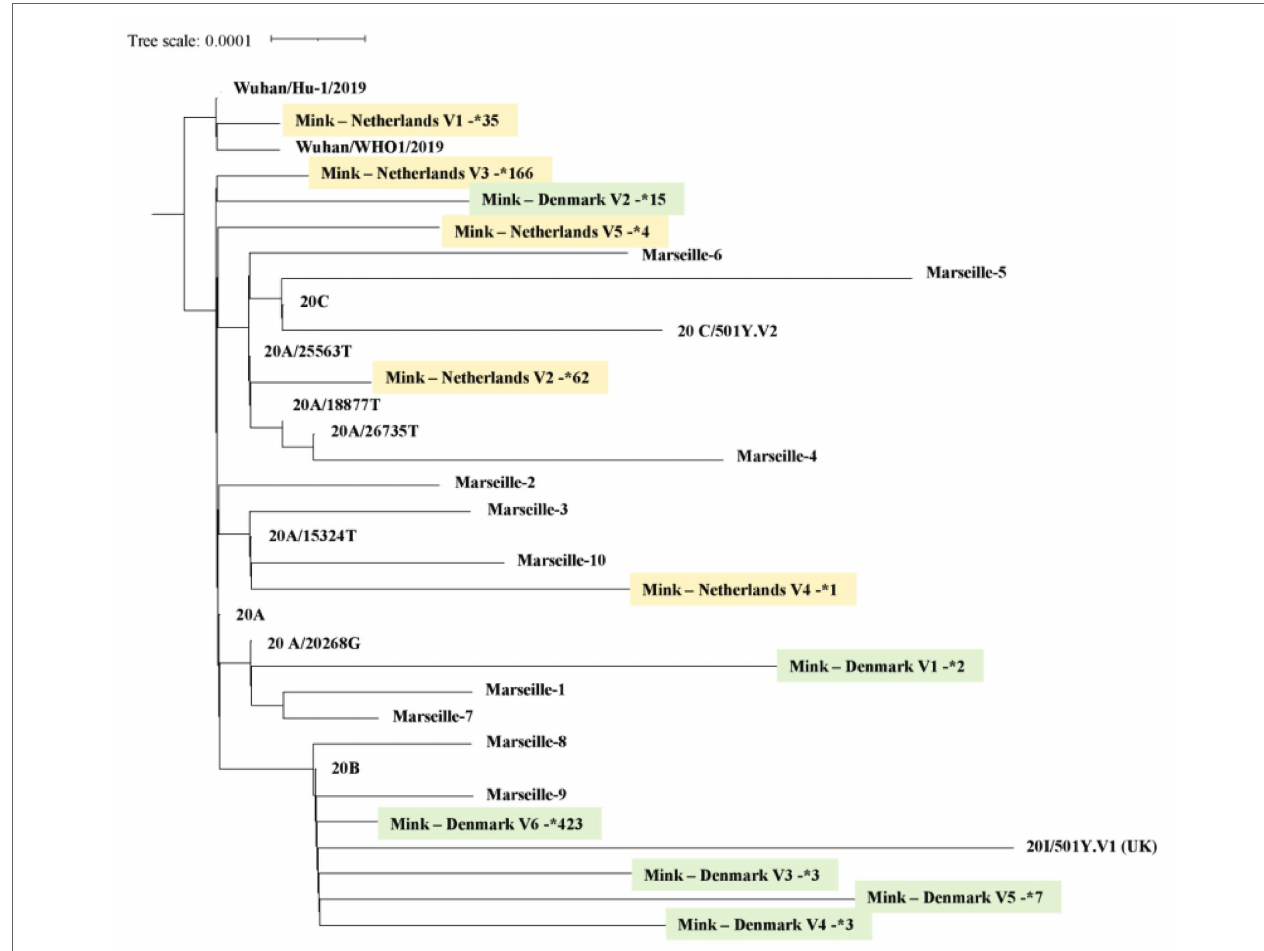
FIGURE 4 | Mink SARS-CoV-2 virus phylogeny. A total of 744 SARS-CoV-2, selected from GISAID (https://www.gisaid.org/), were integrated in a phylogenetic analysis. All genomes were aligned by using MAFFT version 7 (Katoh and Standley, 2013). A phylogenetic tree was reconstructed by using IQ-TREE with the GTR model with ultra-fast bootstrap of 1,000 repetitions (Minh et al., 2020). Sequences of mink from the Netherlands are highlighted in yellow, those from Denmark in green. The number next to the star is the number of genomes available for each mink SARS-CoV-2